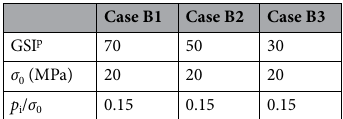
Table 13. GSI, σ 0 and p i / σ 0 for cases B1 to